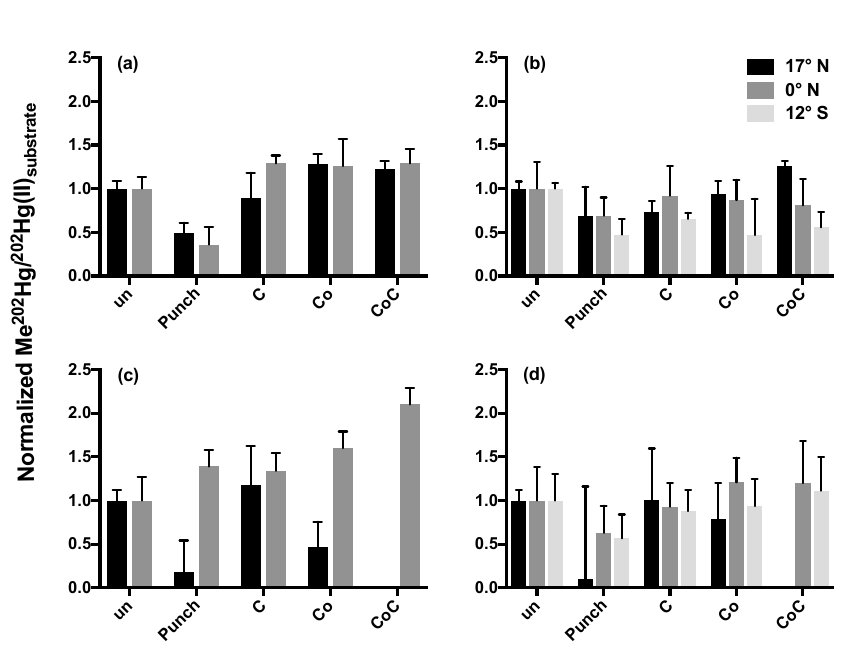
Figure 2. Normalized methylation rates from 24h incubations. Methylation rates from triplicate incubation bottles ( ± 1 SD) normalized to unamended (un) 0.2µm filtered (a, c) and unfiltered (b, d) water from the chlorophyll maxima (a, b) and oxygen minima (c, d) . Treatments are abbreviated as follows: cobalt (Co); succinate (C); in situ pump subsamples